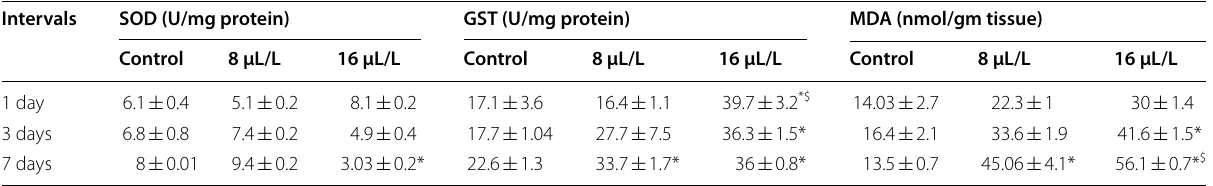
Table 2 Effect of plant growth regulator RIPEX on the activities of SOD and GST and the level of MDA in the digestive gland of the snail Biomphalaria alexandrina